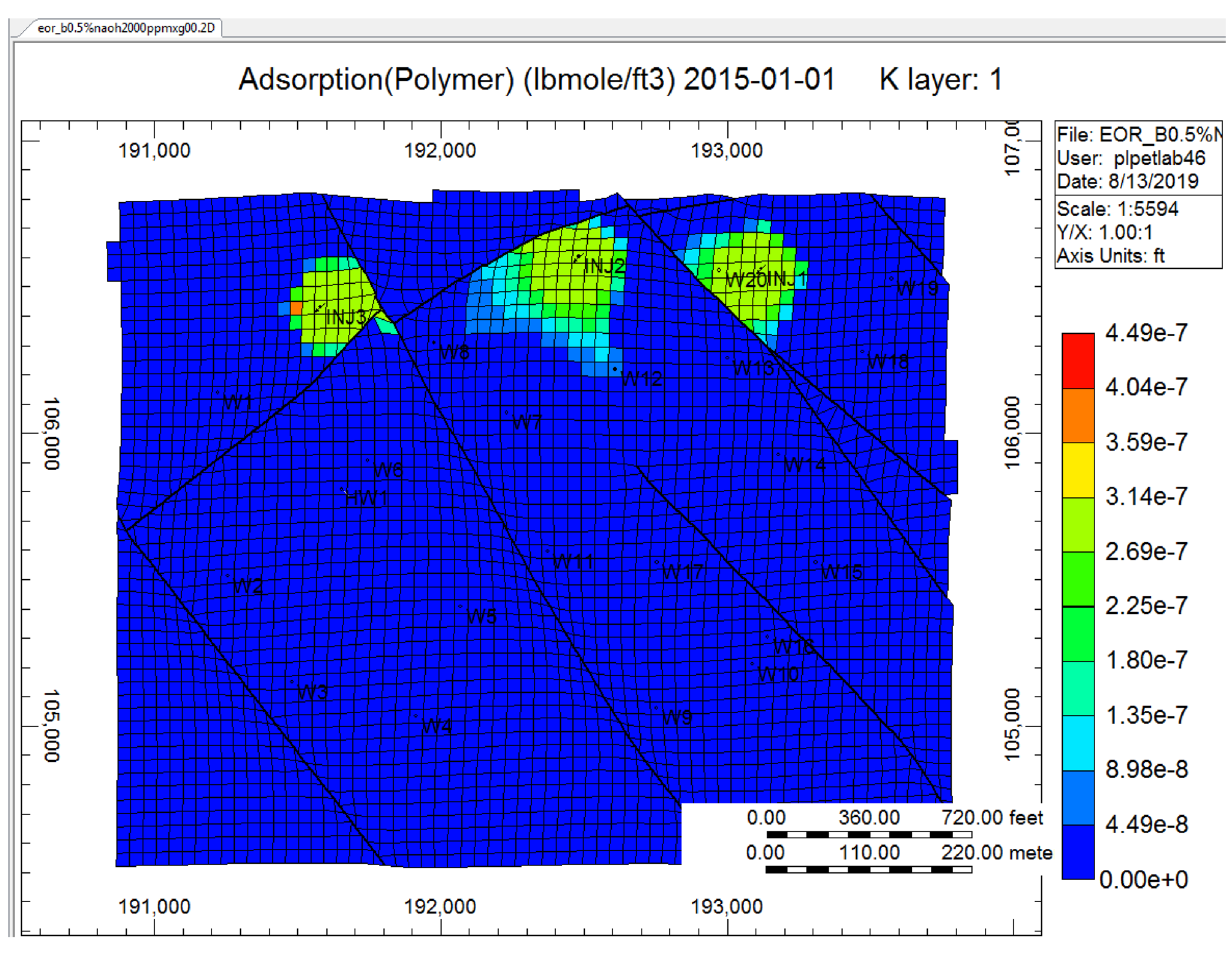
Fig. 14 Adsorption of 2000 ppm Polymer with 0.5% NaOH